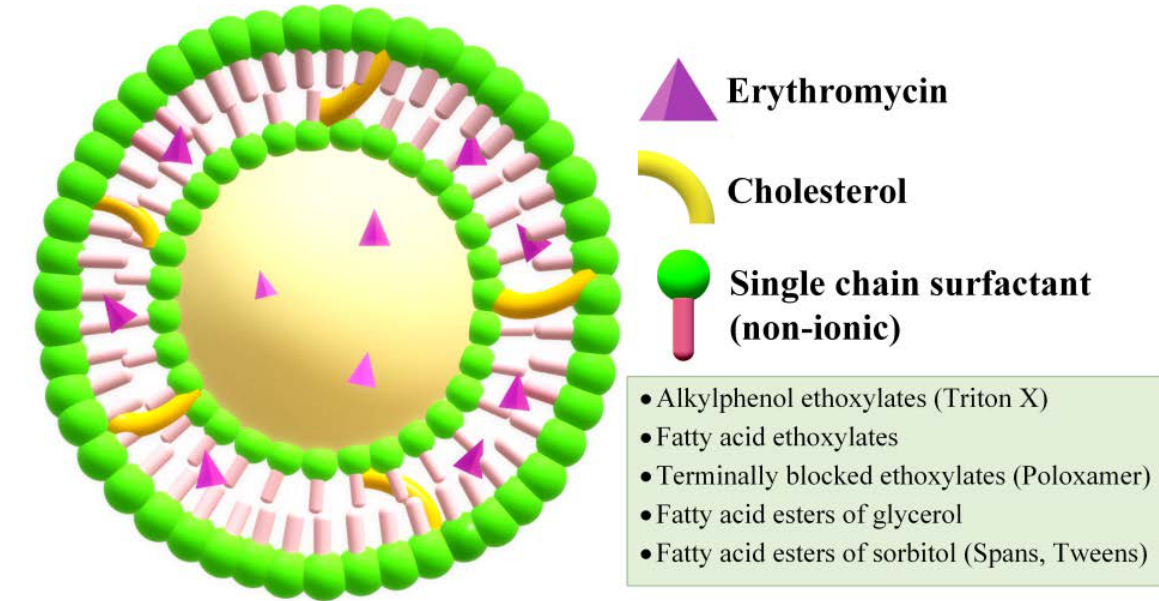
Figure 5 . Schematic representation of an ERY niosome. Figure 5. Schematic representation of an ERY niosome.